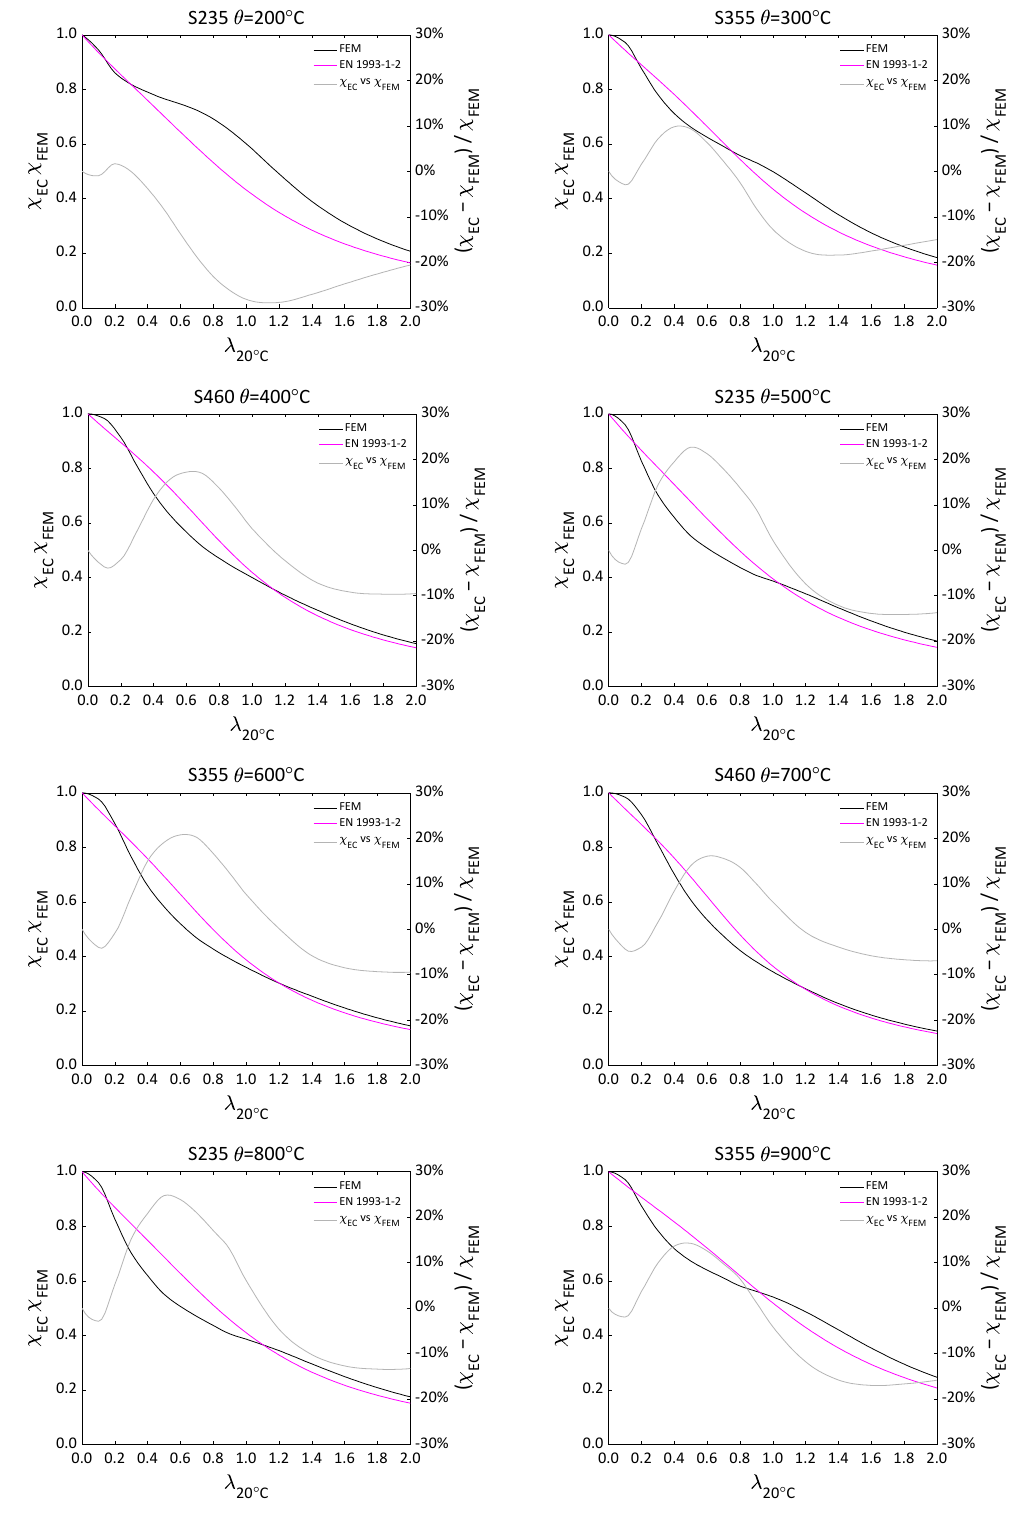
Figure 2. Buckling factors obtained by FEM vs. EN 1993-1-2 for different steel grades and heating temperatures.